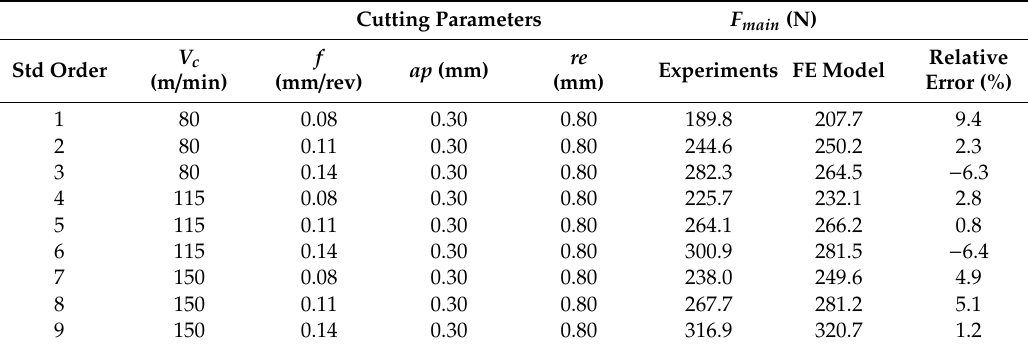
Table 4. Main machining force comparison between the experimental and numerical values. Cutting Parameters